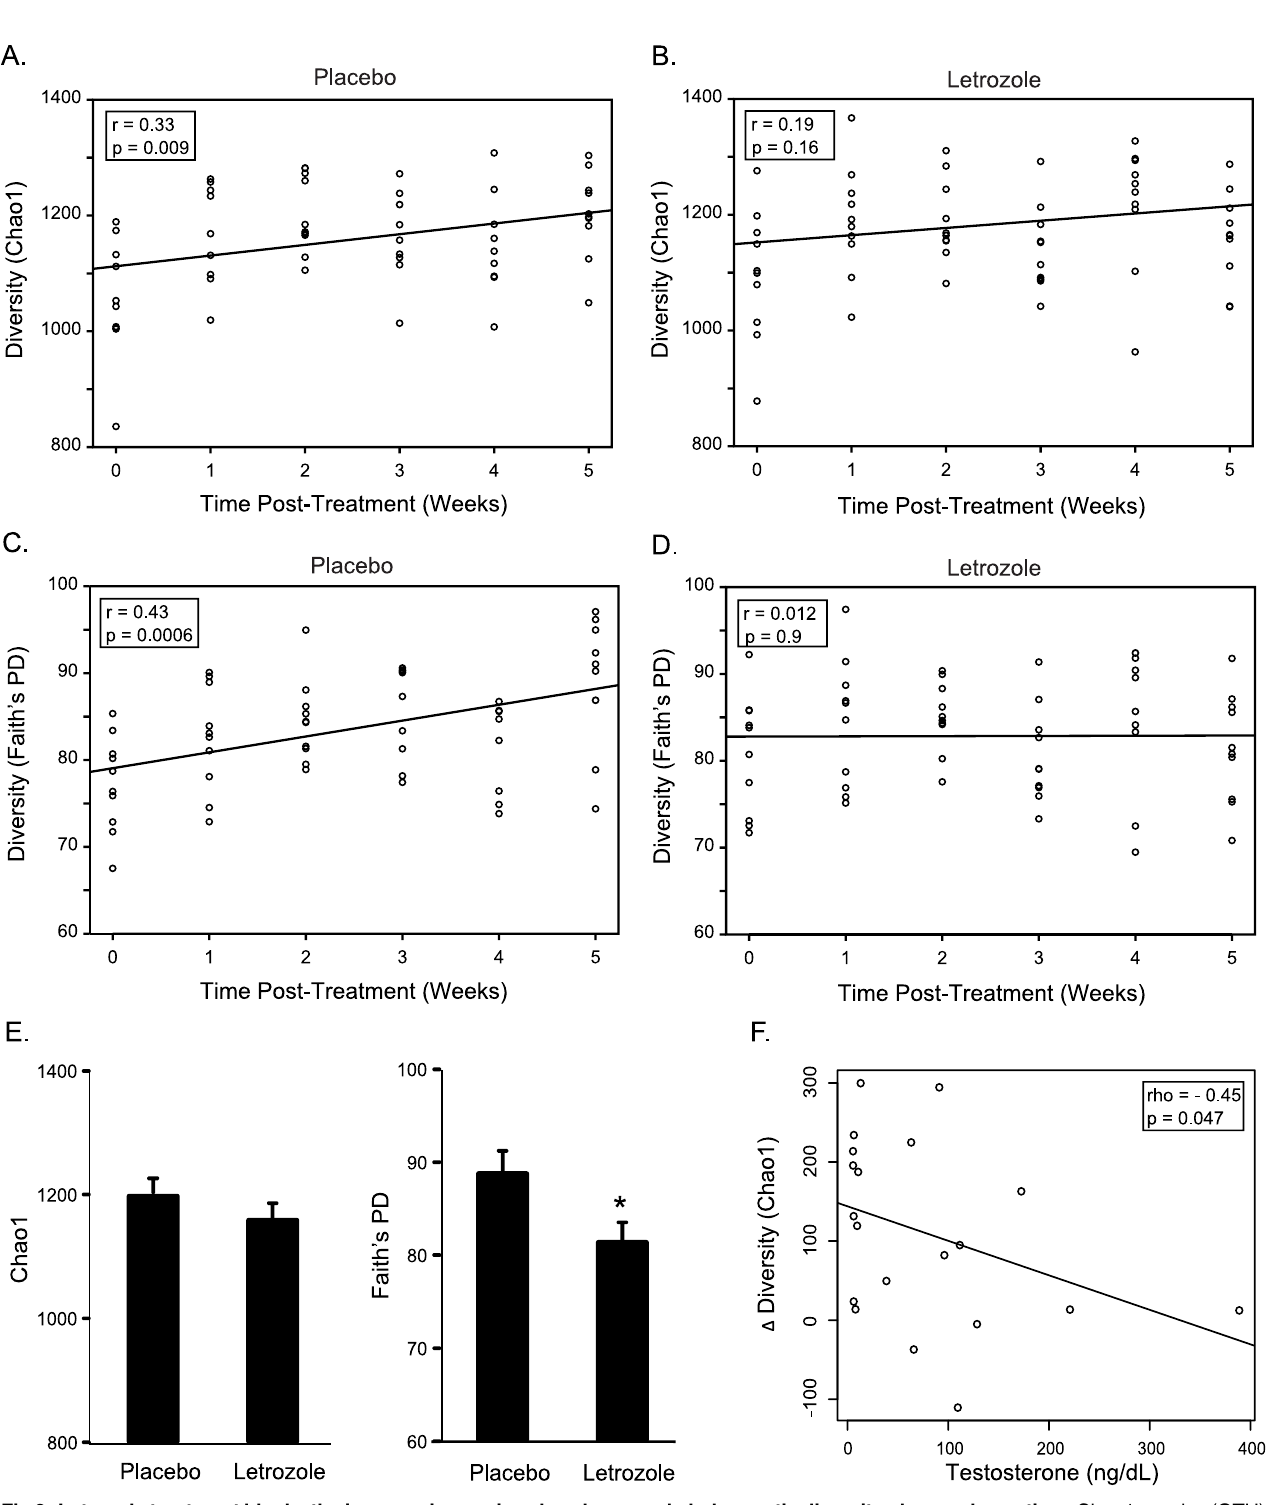
Fig 2. Letrozole treatment blocks the increase in species abundance and phylogenetic diversity observed over time. Chao1 species (OTU) richness estimates per sample at each collection time for placebo (A) and letrozole-treated mice (B). Faith ’ s phylogenetic diversity estimate per sample at each collection time for placebo (C) and letrozole-treated mice (D). Results of Pearson ’ s correlation shown in box inset along with line of best fit. Comparison of Chao1 and Faith ’ s PD after 5 weeks of placebo or letrozole treatment (ANOVA; * p < 0.05) (E), Scatter plot and trend line showing relationship between testosterone levels and change in Chao1 diversity within individuals (time 5 minus time 0) (F). Result of Spearman ’ s correlation shown in box inset.